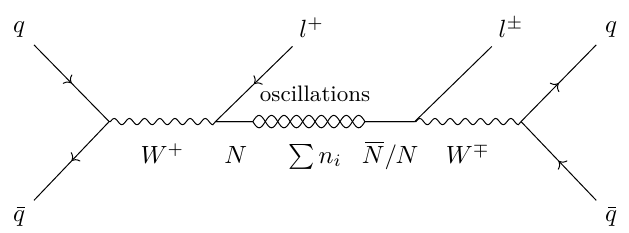
Figure 3 . A neutrino interaction eigenstate is produced together with an antilepton. After some time, the superposition of mass eigenstates n i has oscillated into a heavy neutrino N or antineutrino N interaction eigenstate that decays into an antilepton l + or lepton l − , such that the total process is LNV or